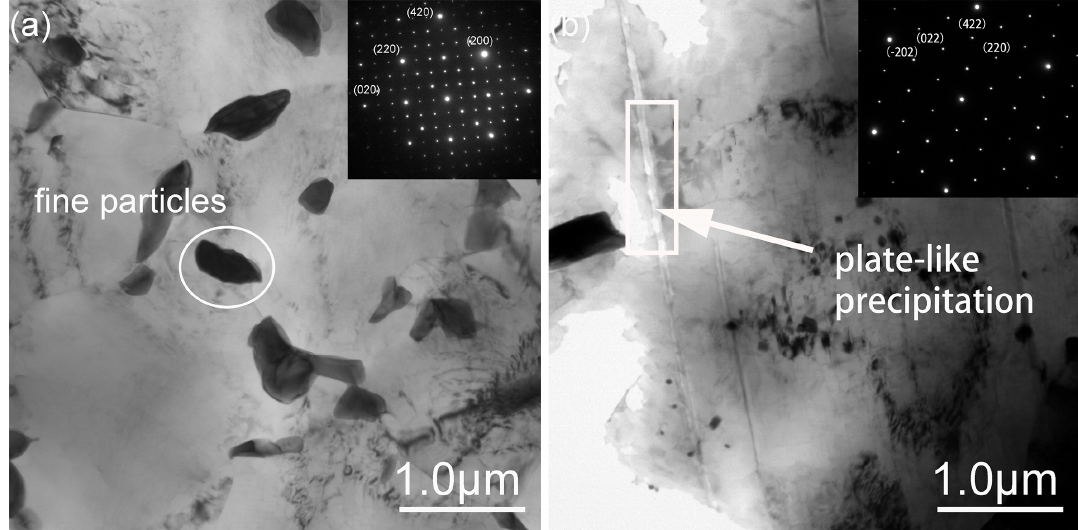
Figure 8. The TEM images of fine particles and plate-like precipitation: ( a ) Fine particles, ( b ) plate-like precipitation.